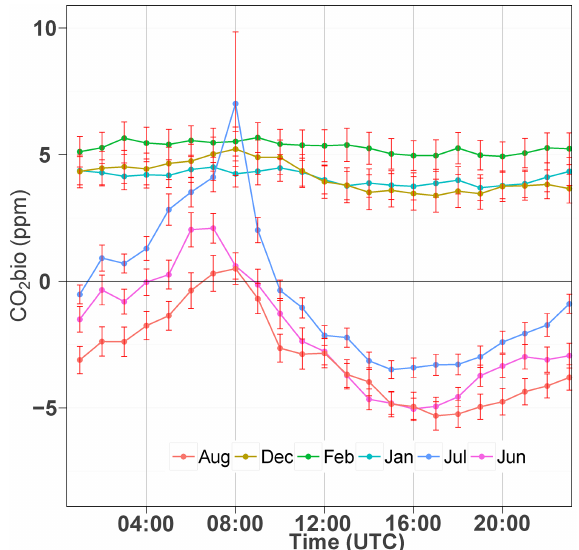
Figure 6. Hourly variations of monthly averaged biospheric CO 2 during summer (June–August) and winter (December–February). While winter values dominated by respiration are constant through- out a day, summer values show a significant diurnal variation in- duced by photosynthesis and vertical mixing. The error bars are the standard deviations of the hourly averaged CO 2bio values for each